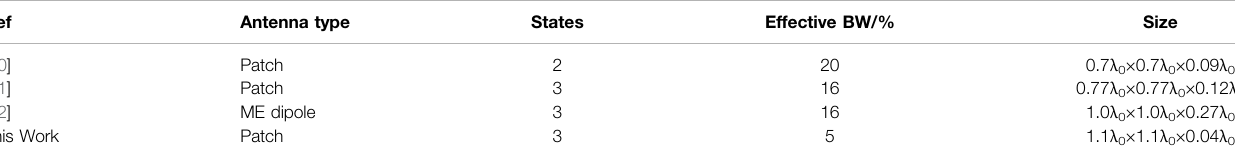
TABLE 3 | Comparison between proposed and other reported polarization recon fi gurable